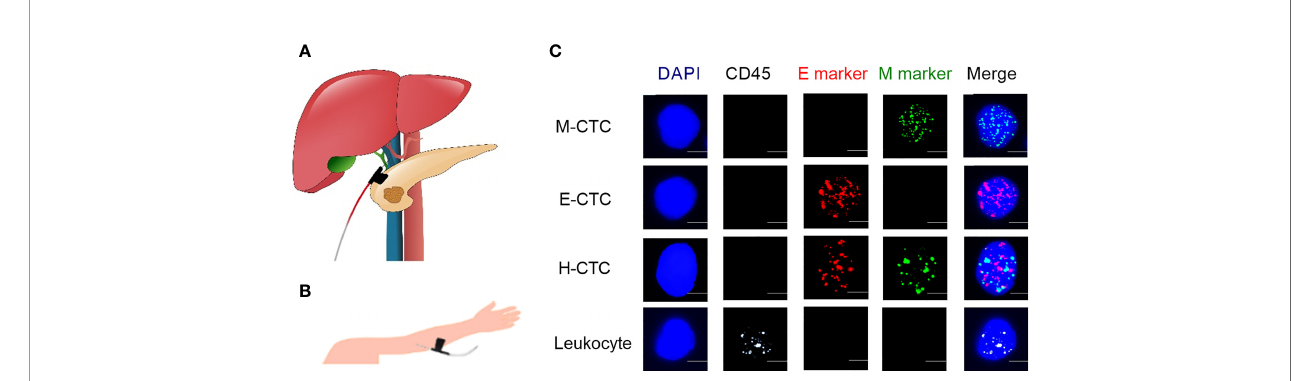
FIGURE 1 | Representative images of PoV, PV blood samples collection and typical multi fl uorescence signals of CTCs and leukocytes. (A) Collecting the portal venous blood sample. (B) Peripheral vessel blood sample was obtained by puncturing the cubital vein. (C) Based on mRNA sequence staining technology, the nuclei were stained with DAPI (blue), the epithelial markers (EpCAM and CK8/18/19) are indicated by red dots, the mesenchymal markers (Vimentin and Twist) are indicated by green dots, and the hybrid CTCs contain epithelial markers and mesenchymal markers are indicated by red and green dots. Leukocyte marker (CD45) is indicated by white dots. Scale bar = 5 m